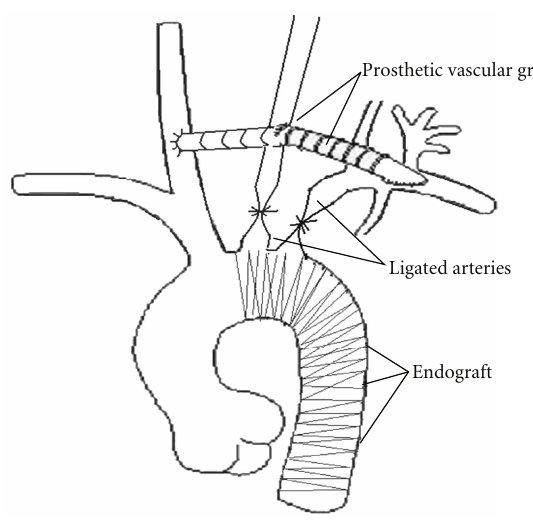
Figure 2: Illustration of the surgical technique. The carotid-to-carotid bypass with subsequent revascularization of left subclavian artery with the proximal segments ligation of the left carotid and left subclavian arteries. Endovascular stenting on the aortic arch and aortic